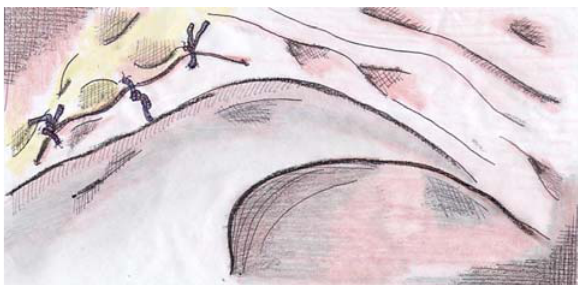
Figure 2 – Diaphragmatic repair completed.